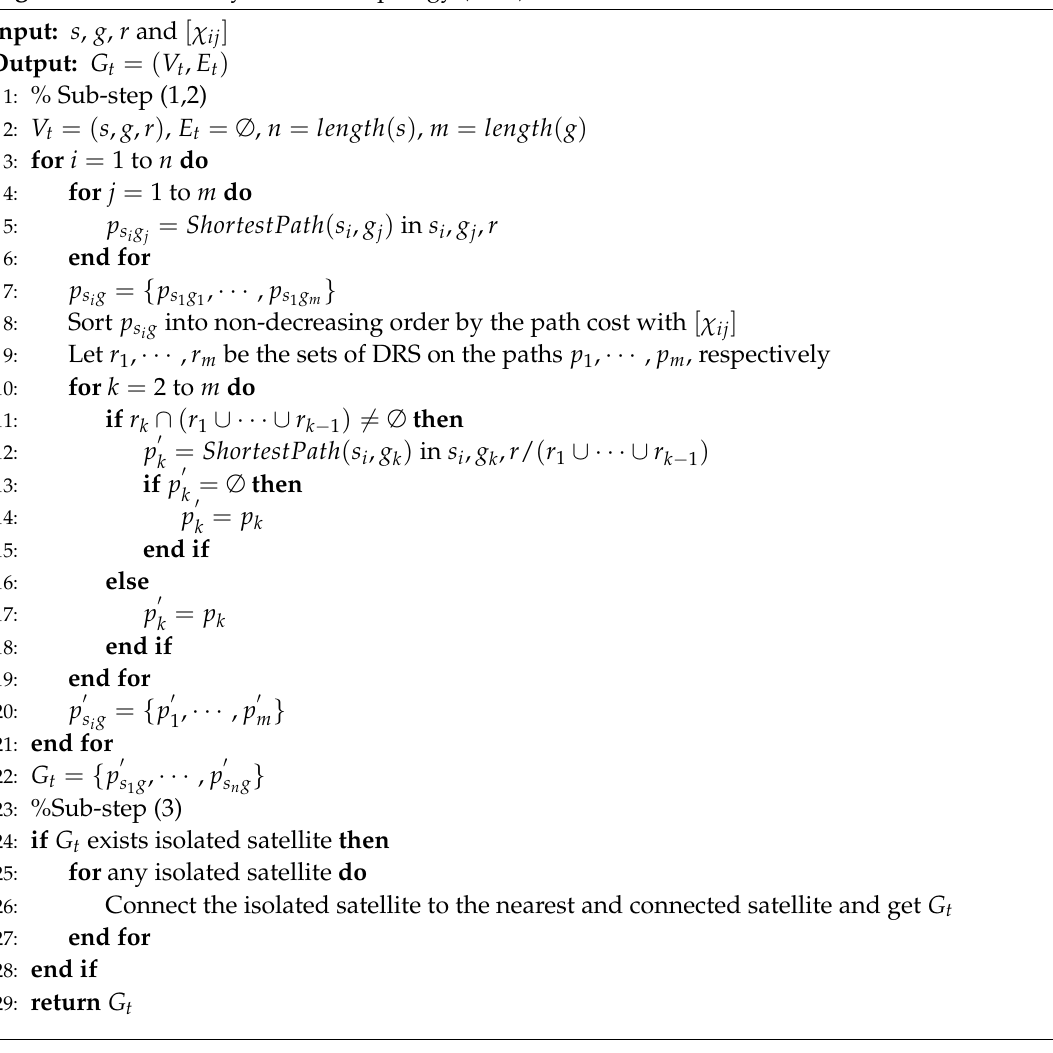
Algorithm 1 Reliability-Assured Topology